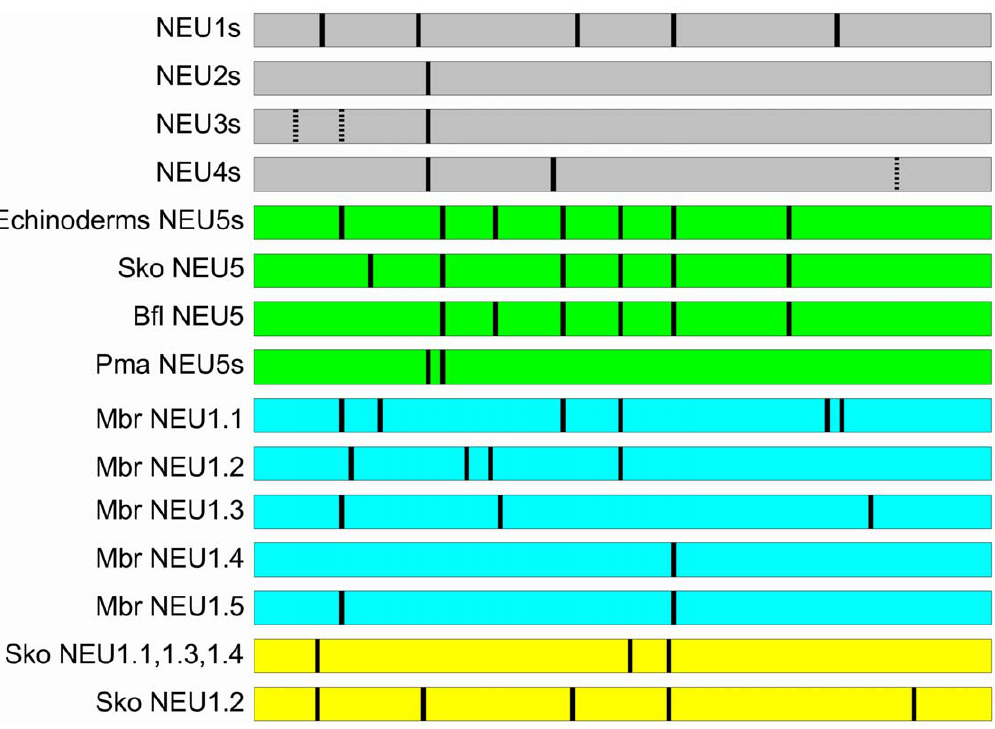
Figure 6. Exon structure analysis. Exon structure of the four already known sialidase subgroups (NEU1–4; grey bars), of the newly identified NEU5 sialidases (green bars), of the 5 sialidases from M. brevicollis (light blue bars) and of the NEU1 sialidases from hemichordate S. kowalevskii (yellow bars). Horizontal bars represent the protein sequence and the position of the exon junctions within the polypeptides are indicated by the black lines. Dotted black lines in NEU3 subgroup indicate additional exons found only in the avian species analyzed ( G. gallus, T. guttata ), while in NEU4 indicate an additional exon find only in X. tropicalis . The bar representation of the protein sequences is not in scale with the exon length, but the reciprocal position of exon junctions in different subgroups are respected.